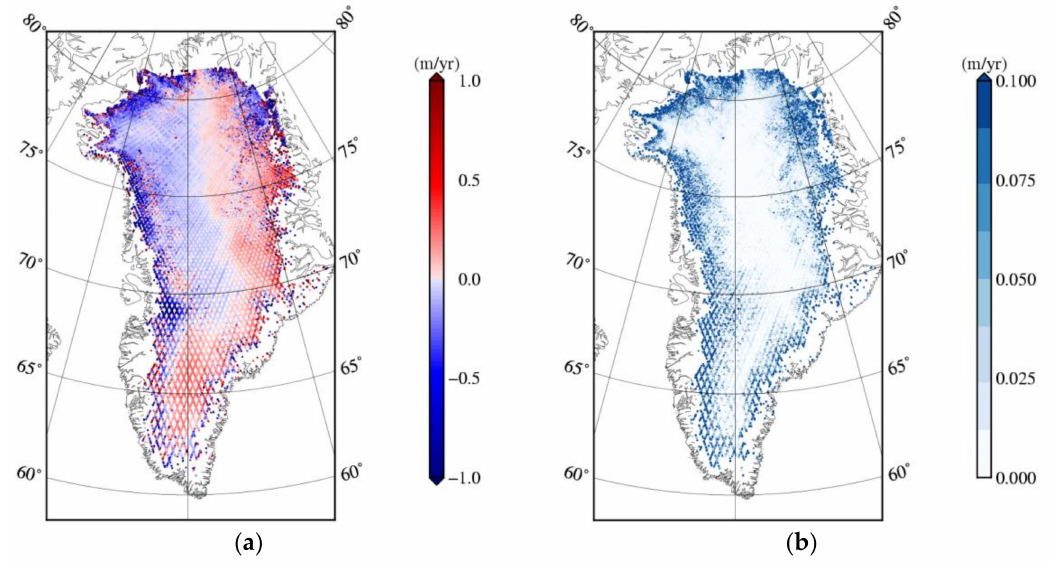
Figure 6. ( a ) Rate of elevation change over the GrIS derived from 2013–2016 SARAL altimetry with the ICE1 retracker. ( b ) The corresponding uncertainties of the elevation change rate derived from SARAL with the ICE1